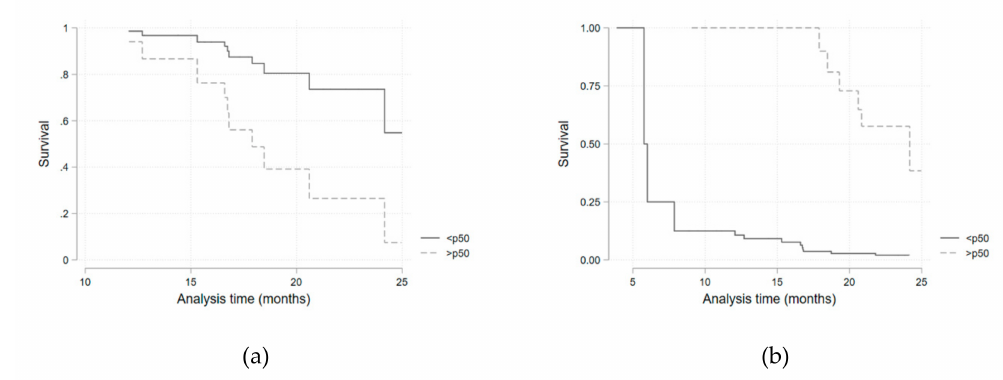
Figure 3. Kaplan–Meier survival curves for transferrin saturation ( a ) and ferritin ( b ) values above (solid lines) or below (dashed lines) the